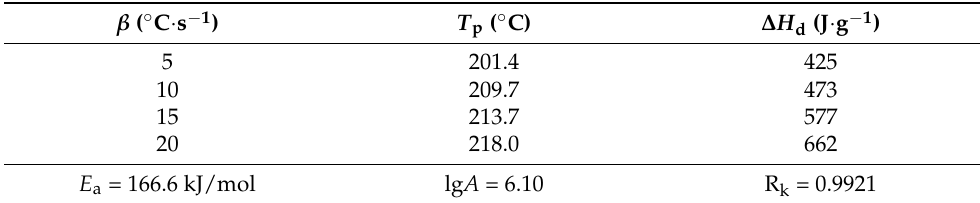
Table 2. Thermal analysis data.